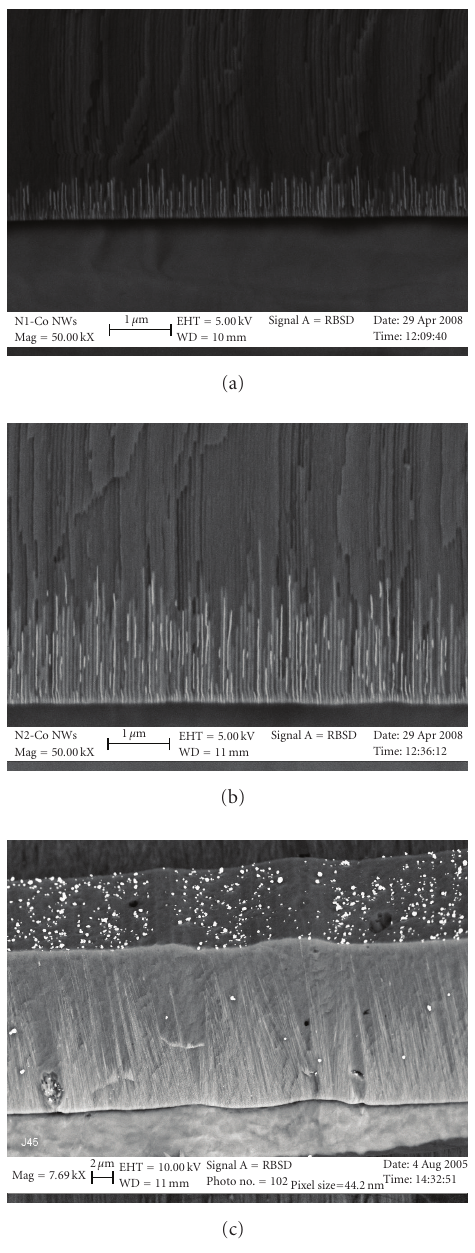
Figure 2: Cross-sectional FESEM images of sulfuric acid alumina templates grown at (a, b) 25 and (c) 15 V following the template etching in 2 M H 2 SO 4 for 15 minutes and deposition of cobalt nw arrays by AC (50 Hz) treatment in a same as in Figure 1 solution at constant AC current density of 0.3 A dm − 2 and room temperature for: (a) 5, (b) 15 and (c) 60 minutes. (a, b) h AAO 18 μ m, Ø pore ∼ 28 and (c) ∼ 20 nm.